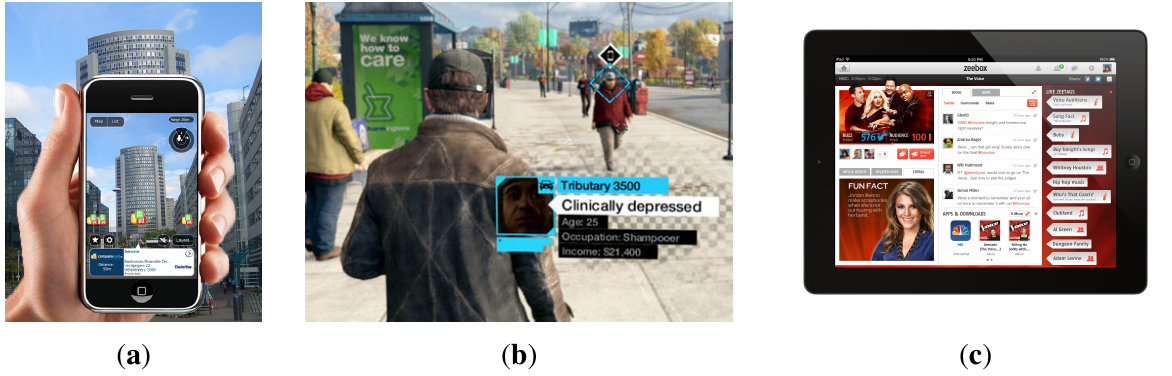
Figure 6. Layar, Watchdogs and augmented television. ( a ) Screen-shot of the Layar app. Additional information is superposed onto the image on the smart-phone. ( b ) Screen-shot of the game Watchdogs. In the game, enriched information is presented in the form of cards with details about characters or objects. ( c ) Zeebox is an augmented television app that shows live information about the current